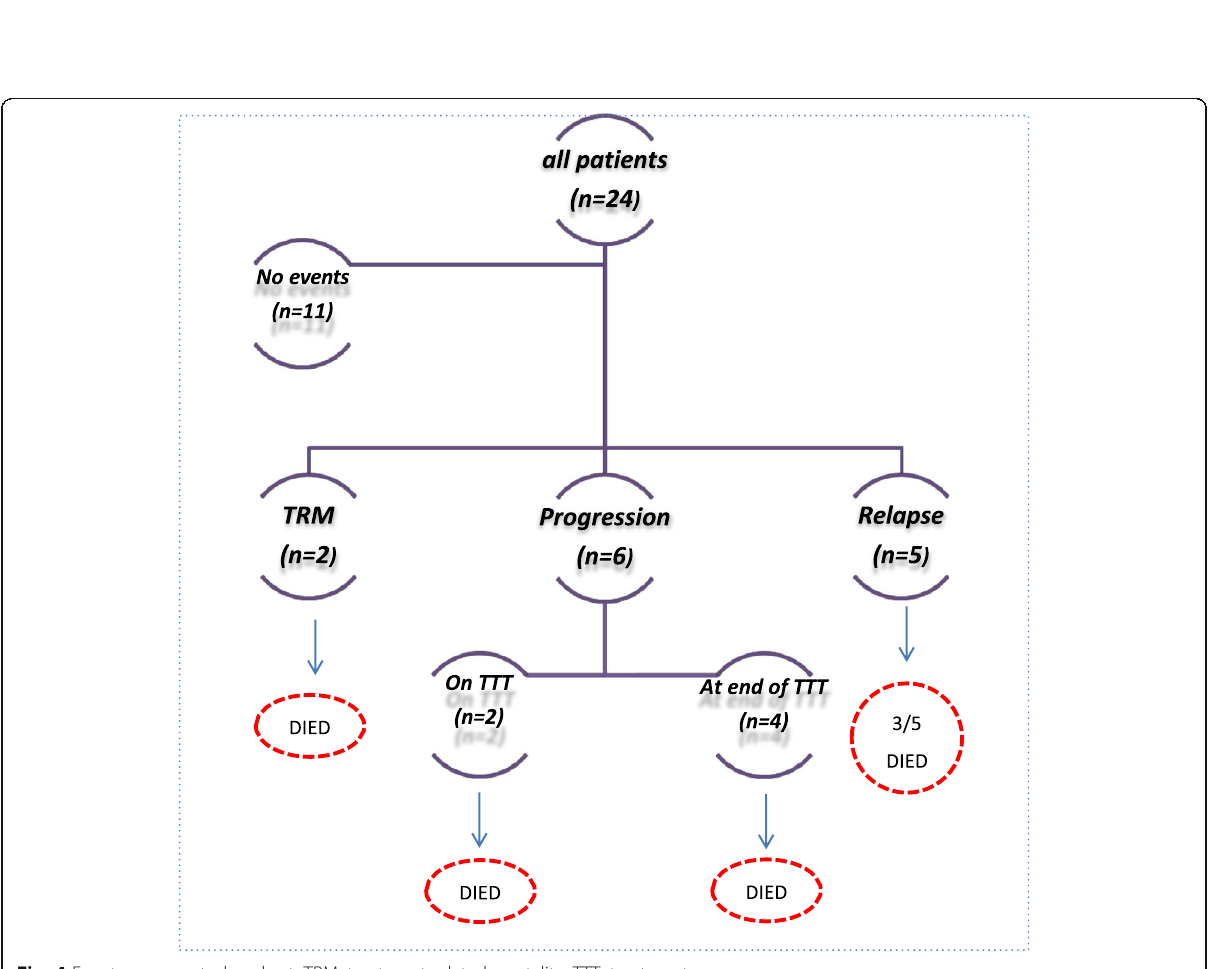
Fig. 4 Events among study cohort. TRM, treatment related mortality; TTT,